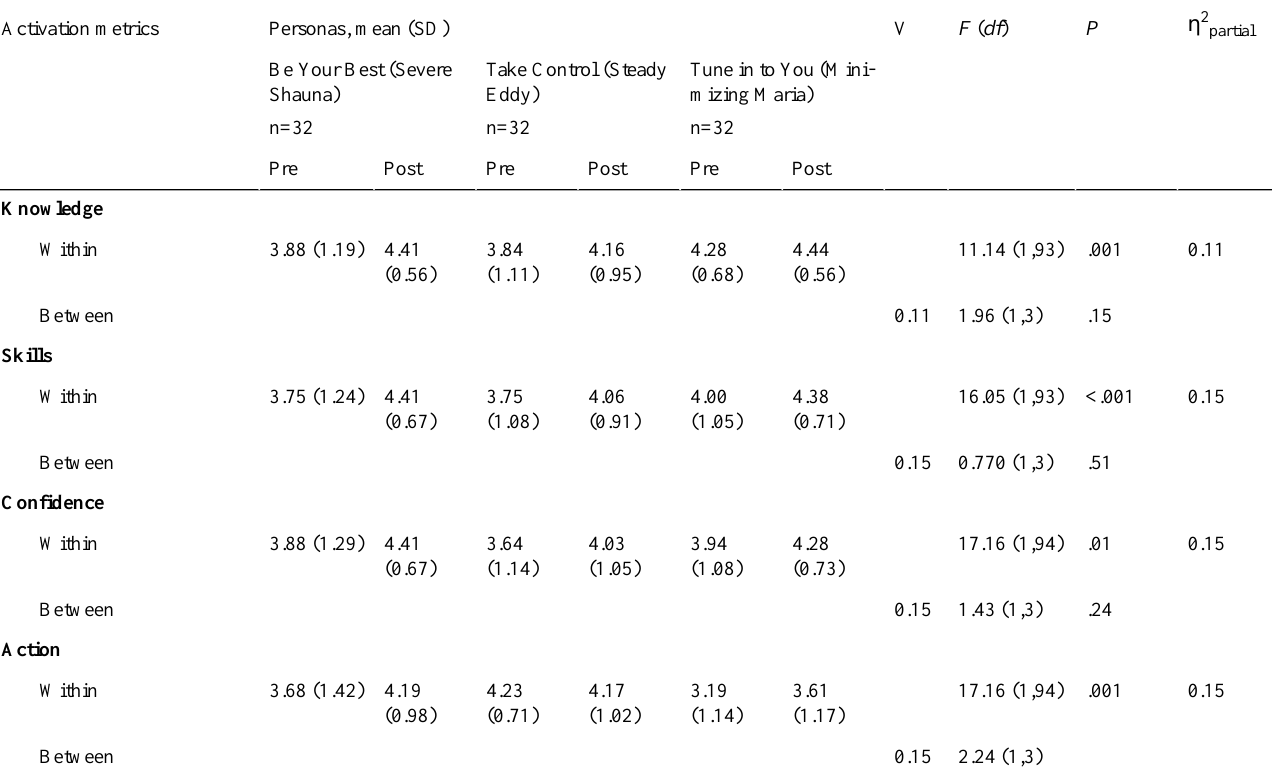
Table 3. Results of general linear model with repeated measures analyses of chronic health disease personas: asthma.